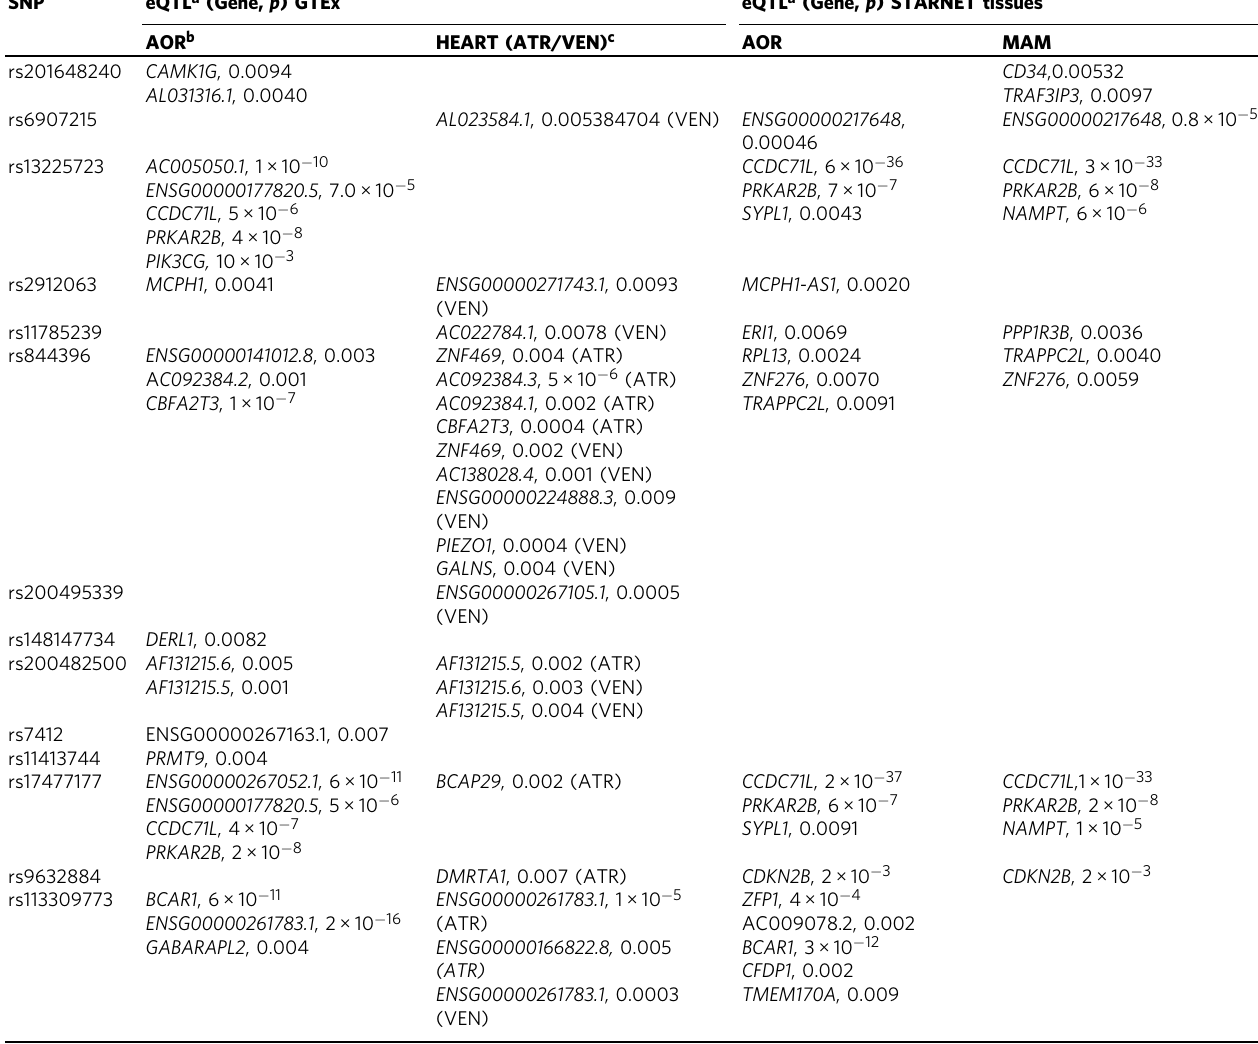
Table 2 Gene expression results for signi fi cant SNPs in GTEx and STARNET tissues